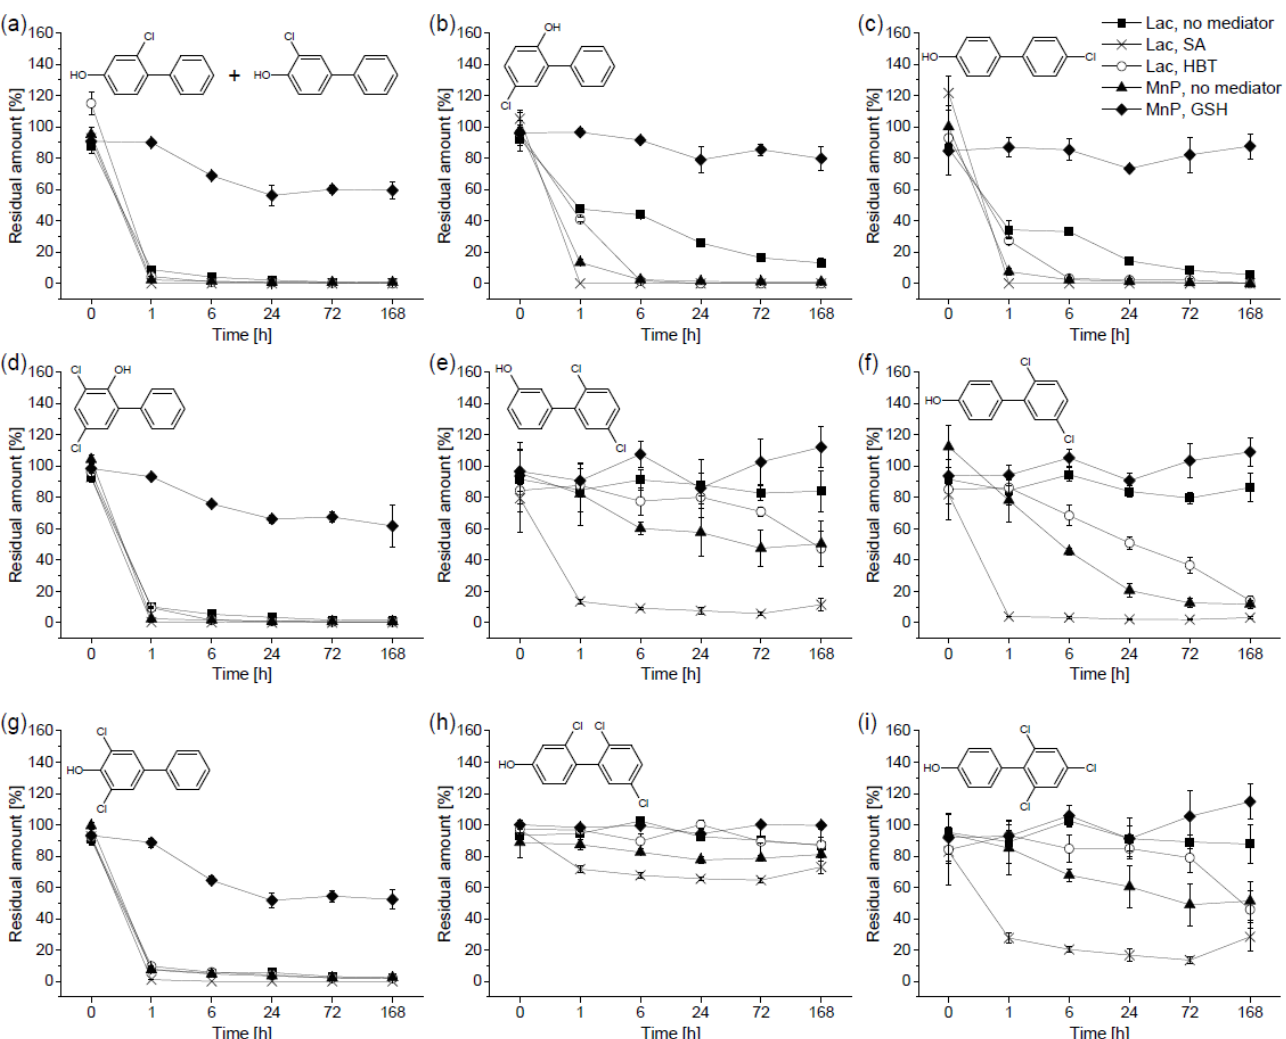
Figure 1. Residual amounts (related to corresponding heat-deactivated controls) of hydroxylated polychlorinated biphenyls (OH-PCBs) obtained during the in vitro experiment with the extracellular liquid of Pleurotus ostreatus : ( a ) 4-hydroxy-2-chlorobiphenyl and 4-hydroxy-3-chlorobiphenyl; ( b ) 2-hydroxy-5-chlorobiphenyl; ( c ) 4-hydroxy-4’-chlorobiphenyl; ( d ) 2-hydroxy-3,5-dichlorobiphenyl; ( e ) 3-hydroxy-2’,5’-dichlorobiphenyl; ( f ) 4-hydroxy-2’,5’-dichlorobiphenyl; ( g ) 4-hydroxy-3,5-dichlorobiphenyl; ( h ) 4-hydroxy-2,2’,5’-trichlorobiphenyl; and ( i ) 4-hydroxy-2’,4’,6’-trichlorobiphenyl. The OH-PCBs were incubated in a mixture; the initial concentration was 2 µg mL −1 for each. The initial enzyme activities were 450 U L −1 of laccase and 30 U L −1 of manganese-dependent peroxidase (MnP). The laccase-favouring setup (Lac) contained no mediator ( ◼ ), syringaldehyde (SA; ✕ ), or 1-hydroxybenzotriazole (HBT; ◯ ); the MnP-favouring setup contained no mediator ( ▲ ) or glutathione (GSH; ⯁ ).